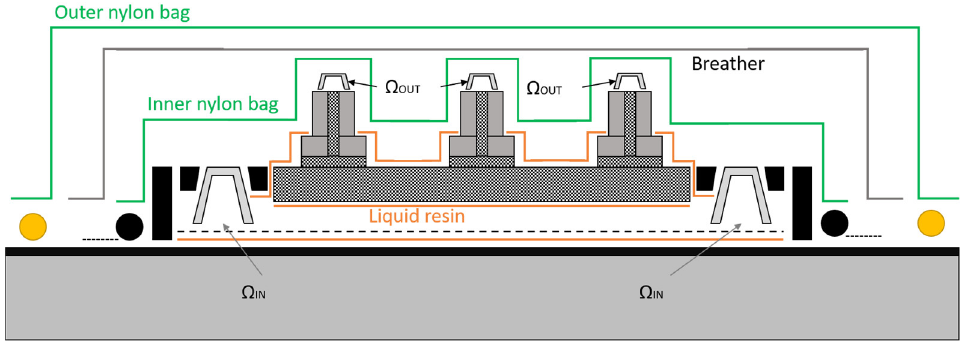
Figure 1. Cross-section of a generic panel “stringerized” and prepared for the infusion.